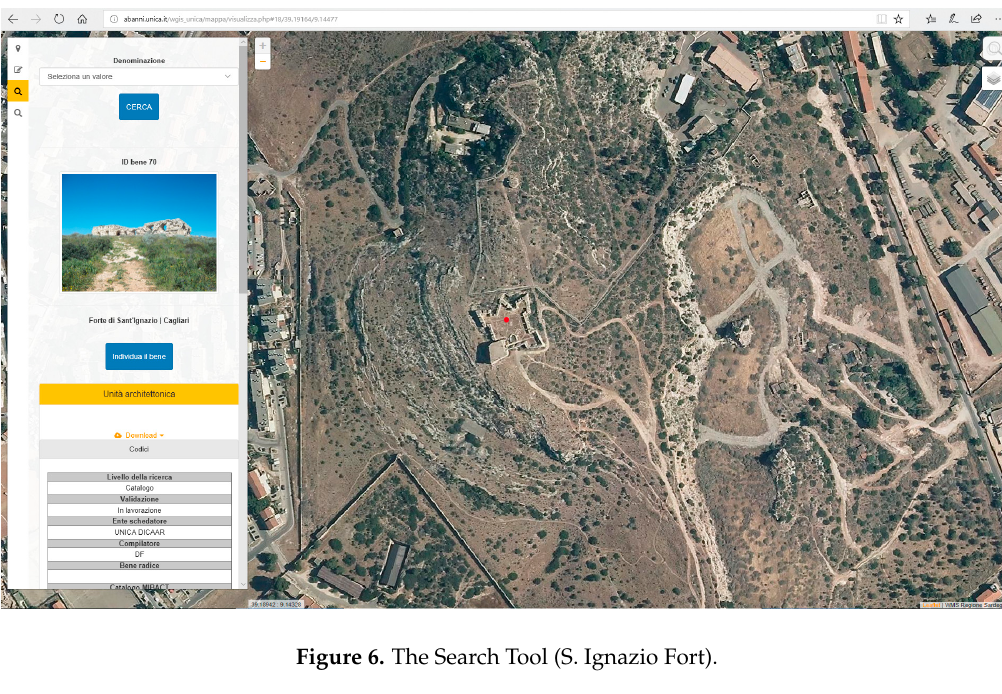
Figure 6. The Search Tool (S. Ignazio Fort).